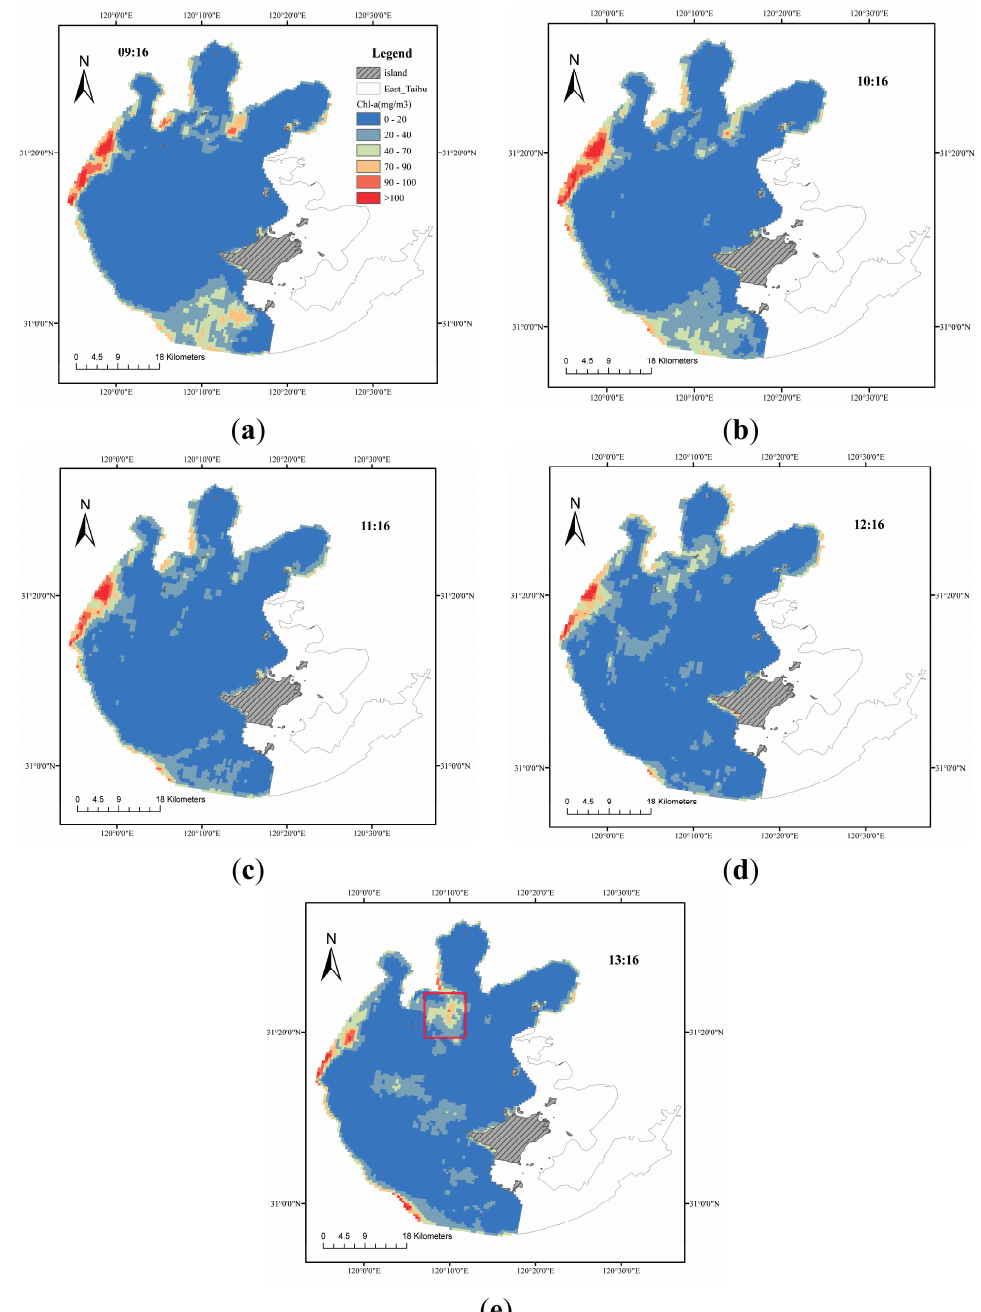
Figure 9. Diurnal distribution of C Chl-a on 3 September 2011 (9:16 a.m. to 1:16